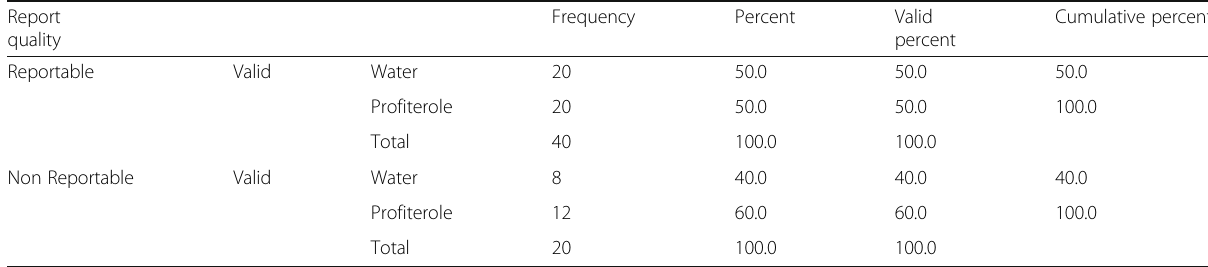
Table 3 Liver clearance agent Report